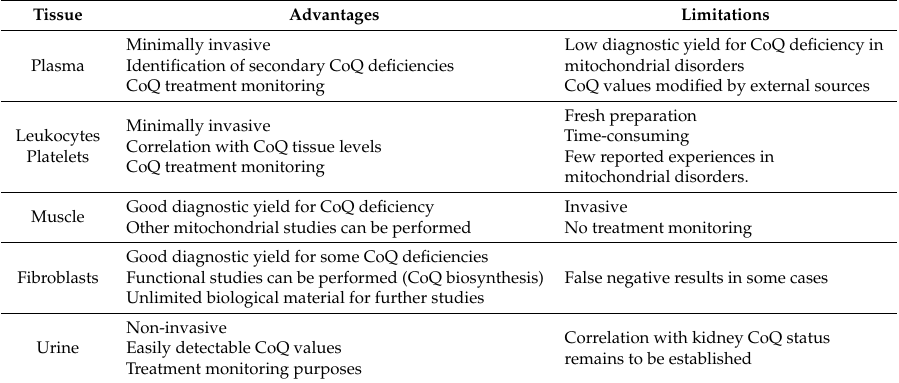
Table 1. Advantages and limitations for the CoQ analysis in different biological